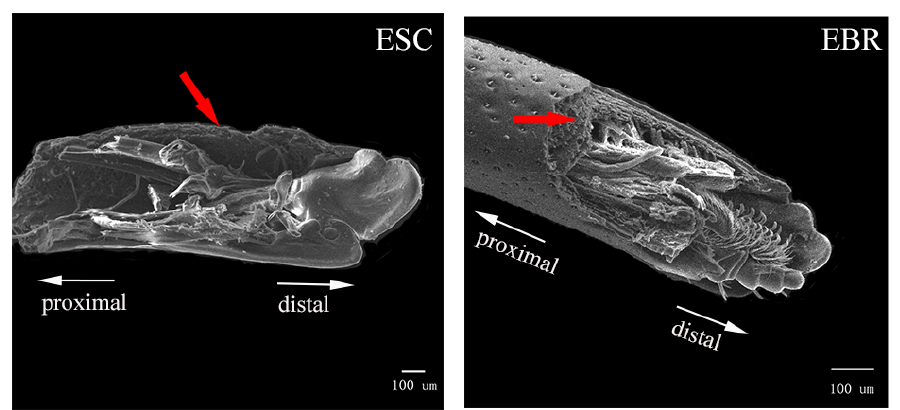
Figure 8. The lamellar microstructure of Eucryptorrhynchus scrobiculatus (ESC) females and E. brandti (EBR) females under scanning electron microscope. The red arrows indicate laminate structures.